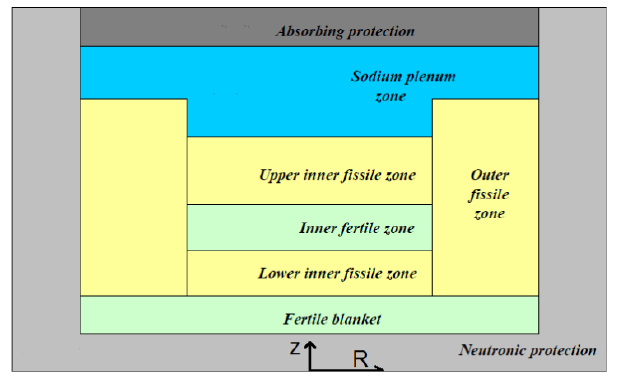
Fig. 1. Scheme of the CFV core concept.